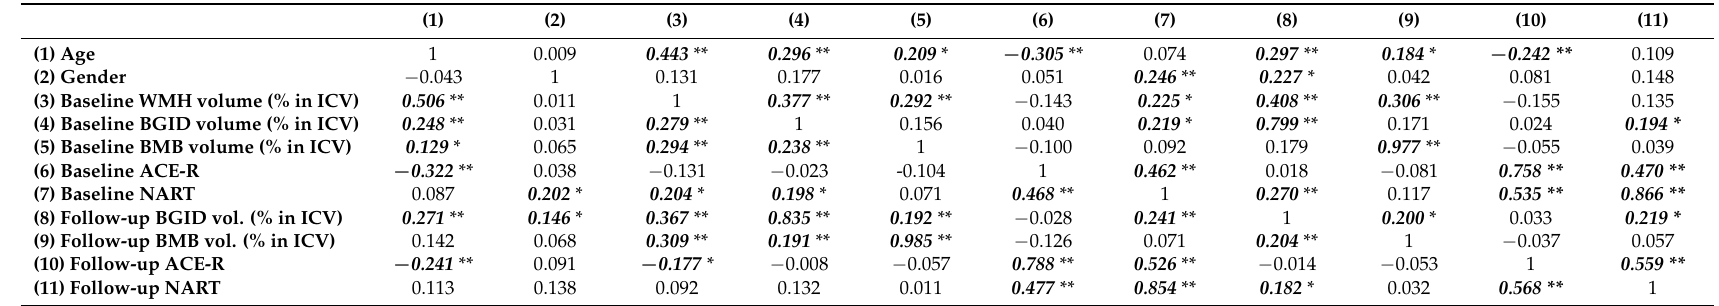
Table 3. Non-parametric bivariate correlations between the imaging and main cognitive variables evaluated, age and gender; with bootstrap (upper right hand side triangle) and without bootstrap (bottom left hand side triangle). analyzed Correlations between all variables (see legend) were analyzed using Spearman’s rank-order correlation. Sample numbers of each variable differed and are reported in the descriptive characteristics of the data sample (Table 1). Spearman ( ρ ) values and indication of the significance level: * p < 0.05, ** p < 0.001 are